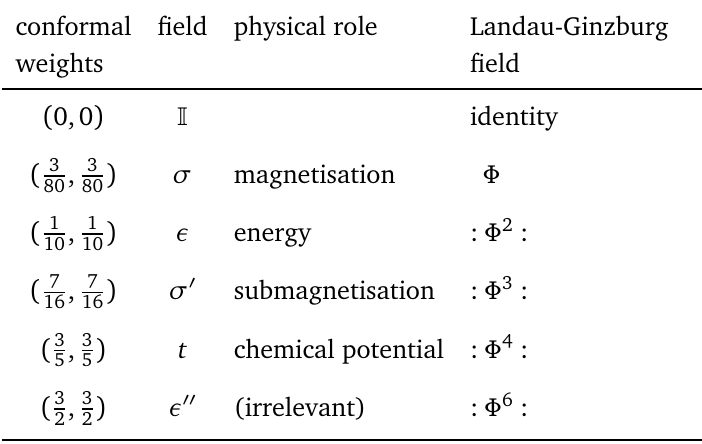
Table 3.2: Primary fields of the TIM and their Landau-Ginzburg identifications